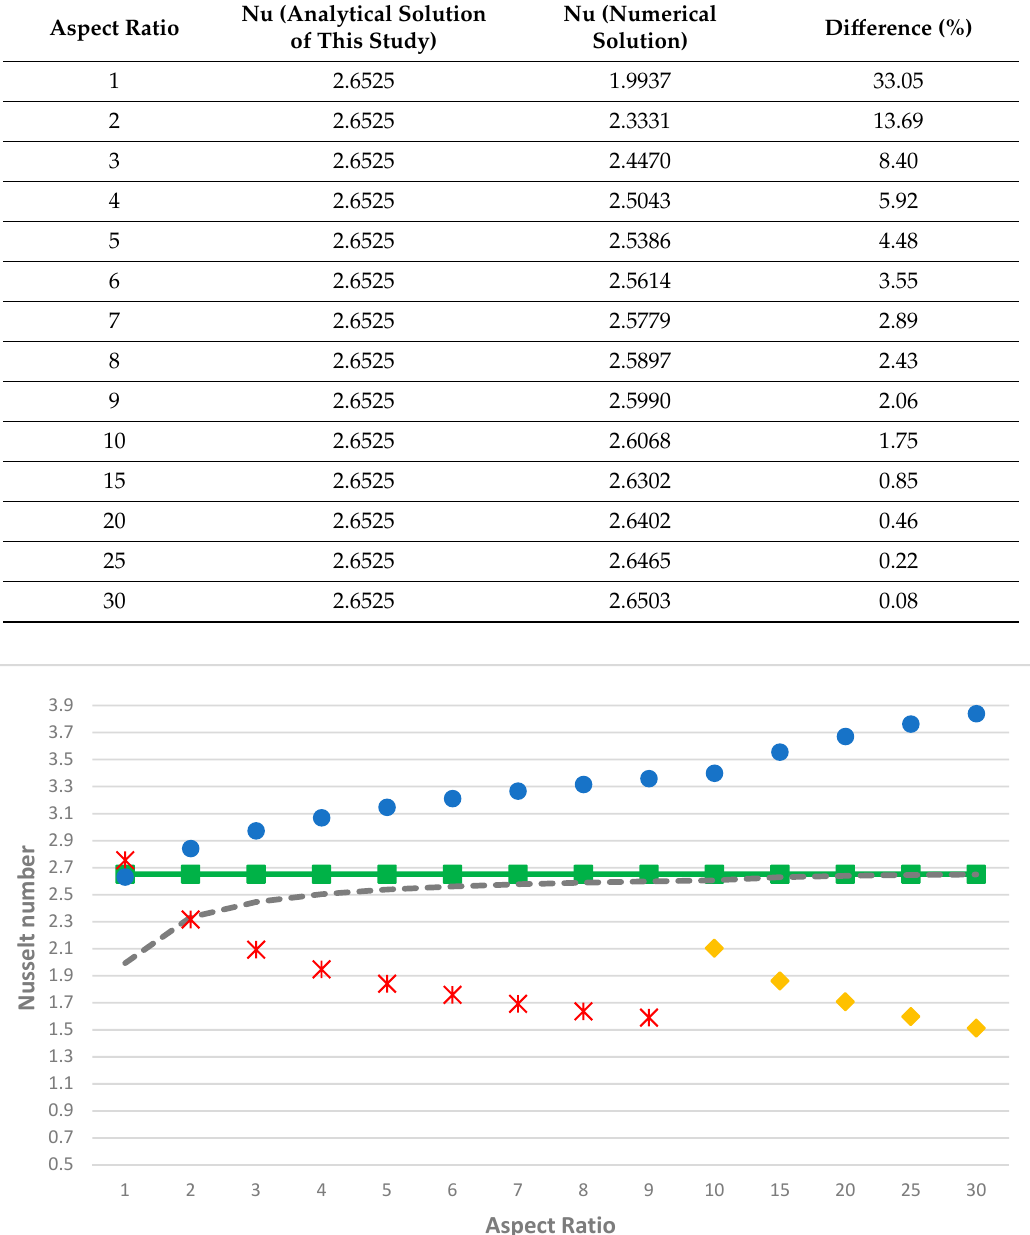
Table 3. Nusselt numbers for the analytical and numerical solutions at varying A and with Ra = 10 4 .